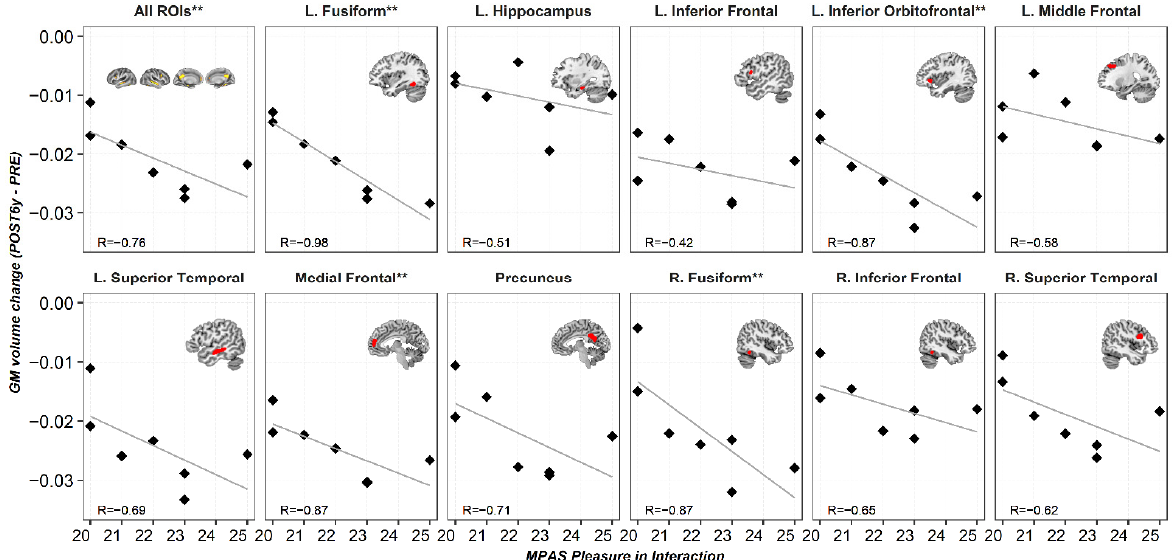
Figure 5. Scatter plots for the Spearman correlations: Y-axis represents gray matter volume changes (POST6y-PRE) for every region of interest, and X-axis represents postpartum scores in the MPAS subscale of “Pleasure in Interaction.” Abbreviations are as follows: L. = left hemisphere, R. = right hemisphere, PRE = pre-pregnancy session, POST6y = six years after parturition session, MPAS = maternal postpartum attachment scale, R = Spearman correlation coefficient, and FDR = false discovery rate. ** Asterisks indicate correlations at q < 0.05 FDR-corrected for multiple comparisons.